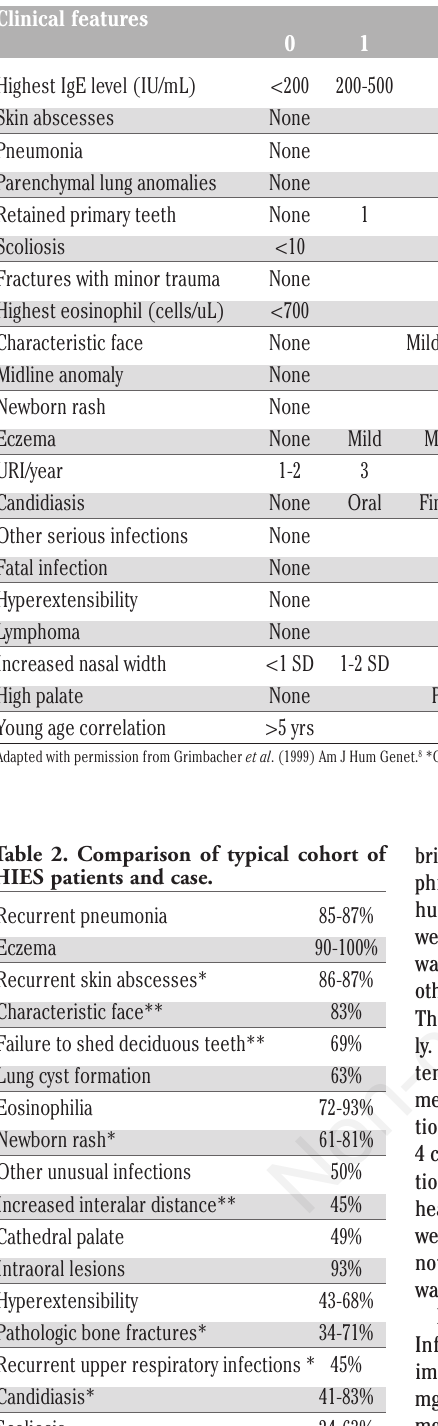
Scoliosis 24-63% Midline anomaly 14% Adapted from Woellner et al. 3 and Sowerwine KJ et al. 13 *Case fea- tures. **Age dependent features.